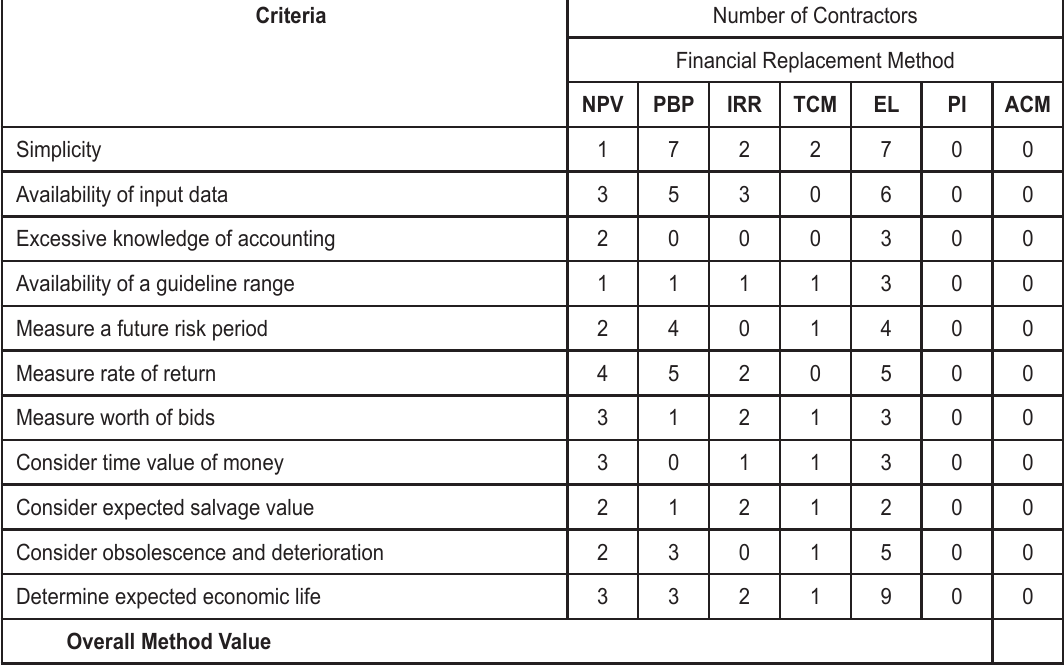
Table 7: Extent of use of the financial methods The results indicate that the majority of contractors use payback period, economic life, and net present value methods in the financial equipment replacement analysis. The payback period (PBP) is the period of time after which the investor will recover his money back or the time required until the equivalent revenues exceed the equivalent capital overlays. The prime objective of the method is to measure how many years the invested money